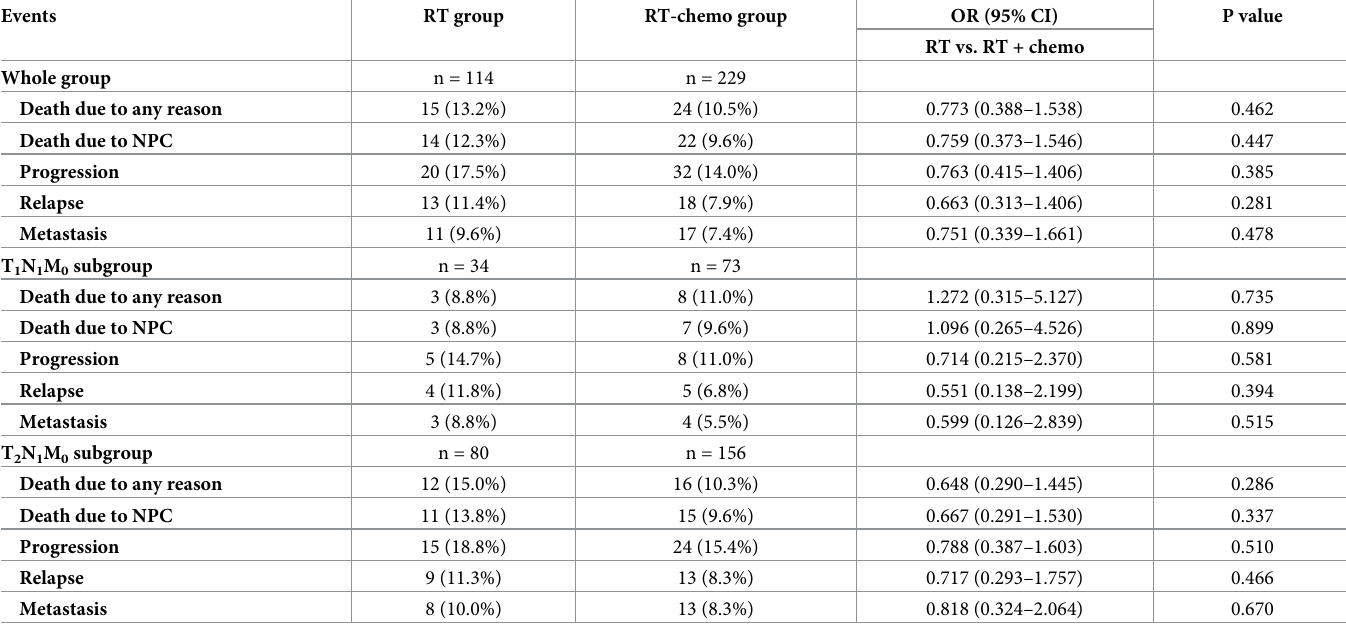
Table 2. Comparison of events incidence between the RT and RT-chemo